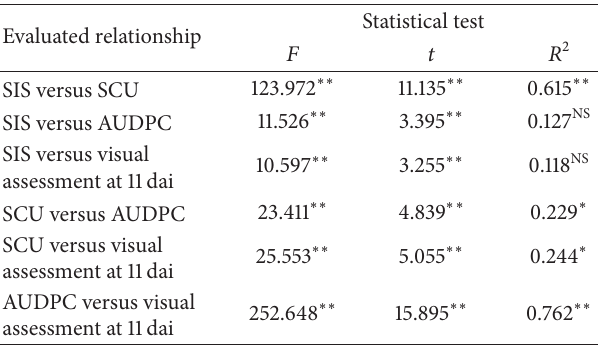
Table 3: Statistical tests applied to the analysis of linear regression between the methods of assessing blast severity on rye and triticale